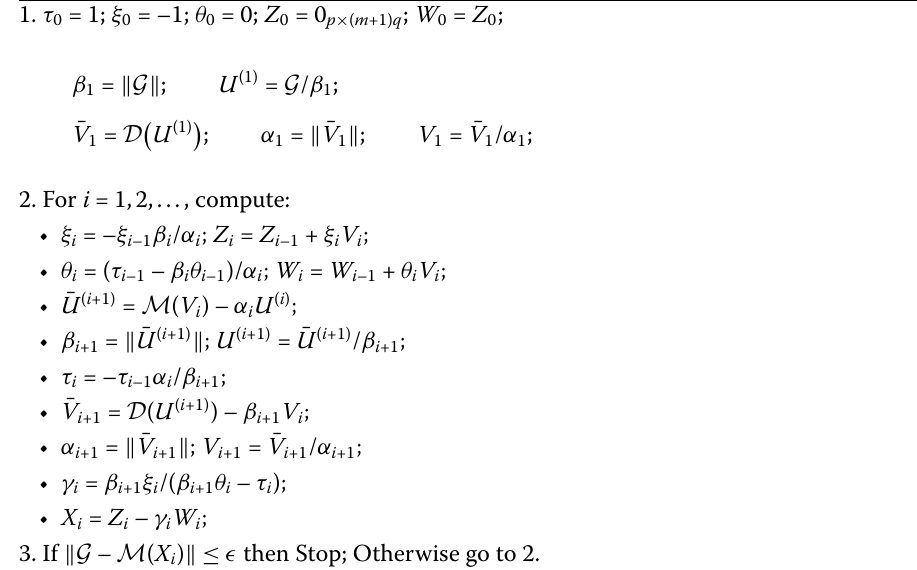
Algorithm 2 The process of solving matrix equations